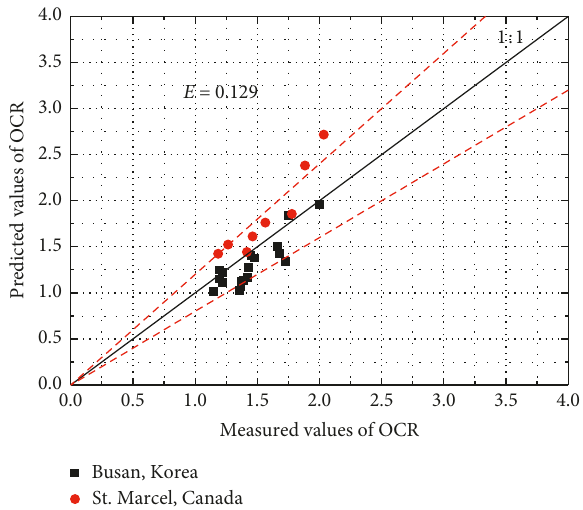
Figure 11: Comparison of the measured values and predicted values of the OCR using Method 2.